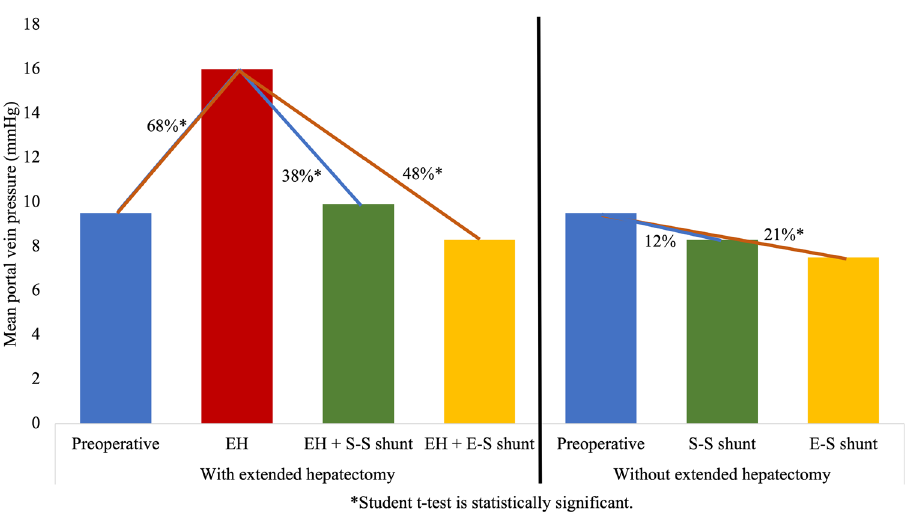
Figure 3. PVP changes with and without EH in three steps without PCS, with a side-to-side portocaval shunt (S–S PCS) and with an end-to-side portocaval shunt (E–S PCS). (1) EH increases the PVP by 68%; (2) S–S PCS reduces the PVP following EH by 38%; (3) S–S PCS reduces the PVP without EH by 12%; (4) E–S PCS reduces the PVP following EH by